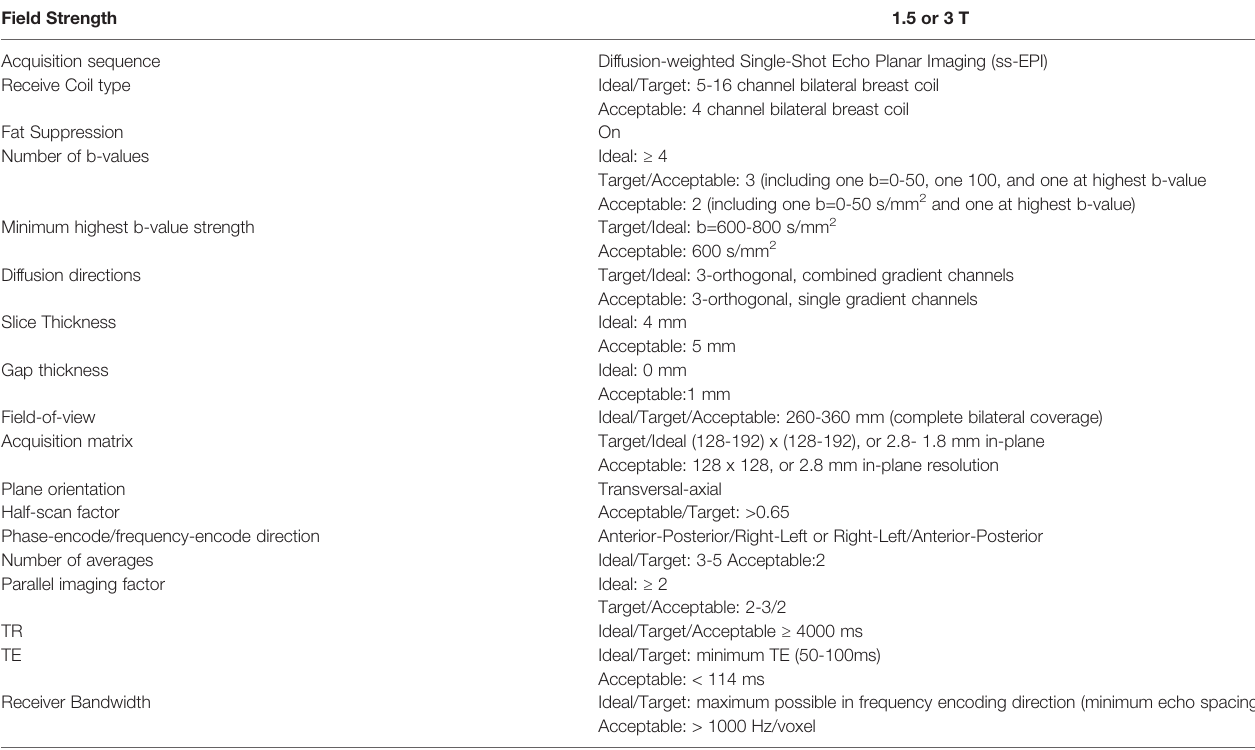
TABLE 1 | Protocol guidance for diffusion weighted imaging of the breast provided by the QIBA. Field Strength